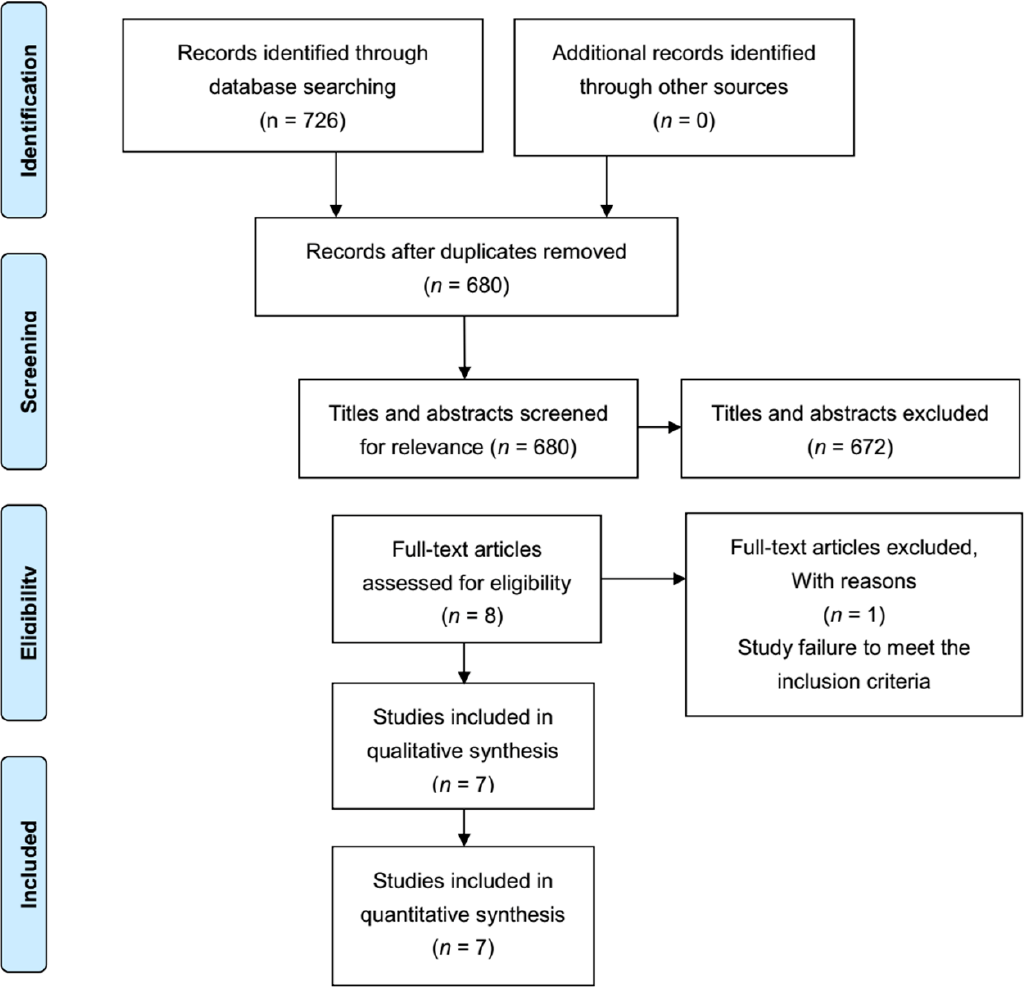
Figure 1. PRISMA flow chart of literature search. Table 1. Characteristics and Primary Outcomes of Included Studies.